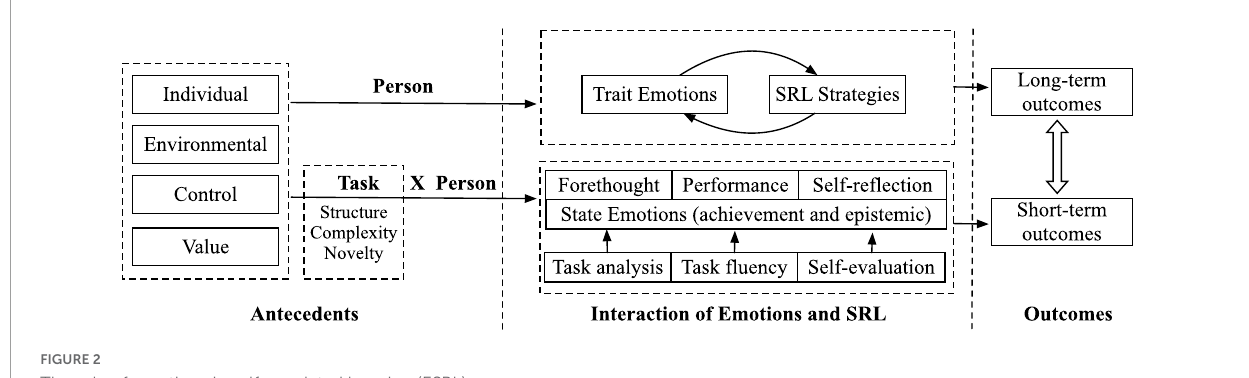
FIGURE2 The role of emotions in self-regulated learning